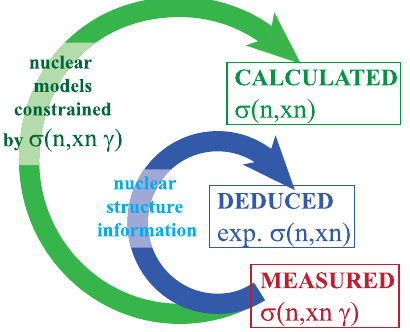
Fig. 1. Schematic view of the two ways to deduce total (n,xn) cross section from measured (n,xn g